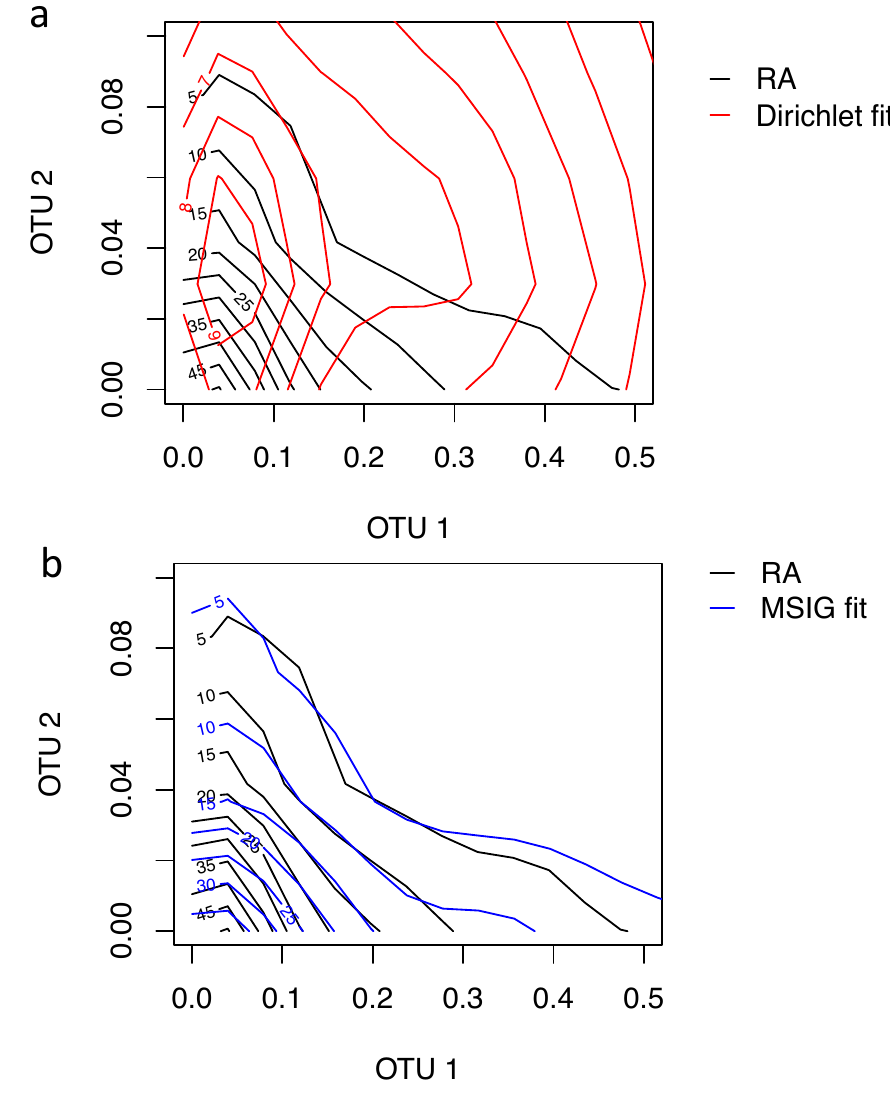
Figure 3. A comparison of contour plots between MSIG and Dirichlet distribution. The black lines are the estimated contour plots of samples. The red lines are the contour plots of the estimated Dirichlet distribution ( a ). The blue lines are the contour plots of the estimated MSIG ( b ). Black lines in both panels are the estimated contour plots for samples. Red lines in the left panel are the contour plots of the estimated Dirichlet distribution. Blue lines in